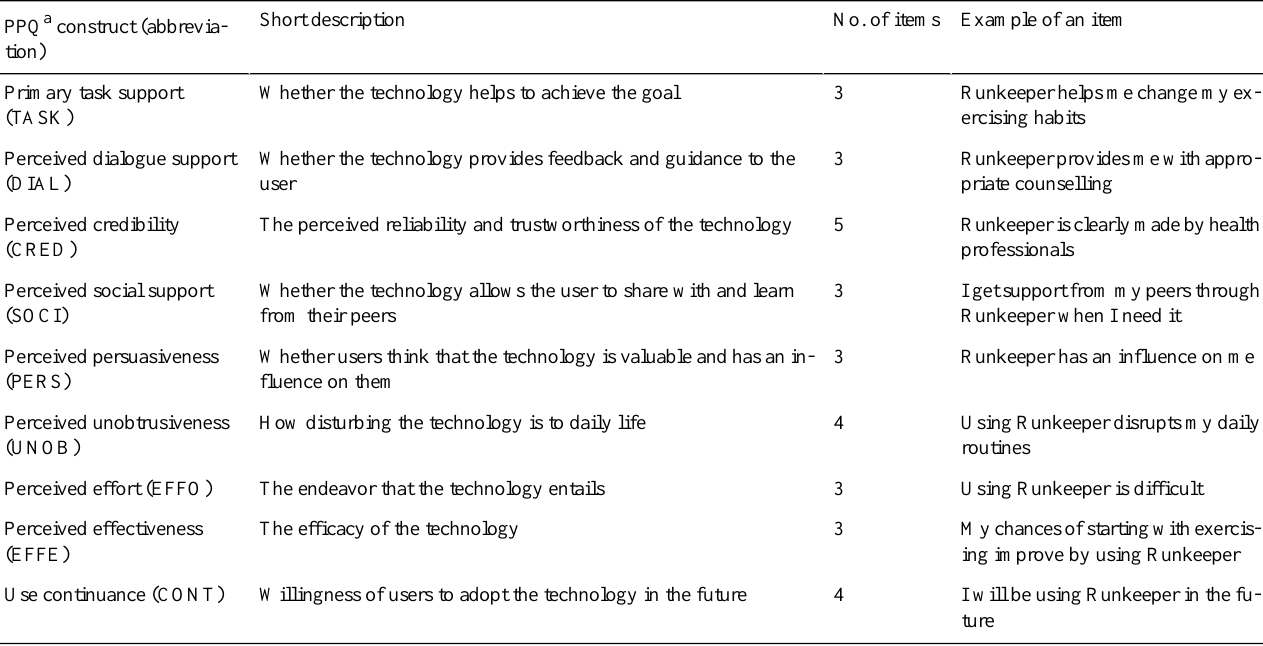
Table 2. Short overview of Perceived Persuasiveness Questionnaire constructs and examples of their